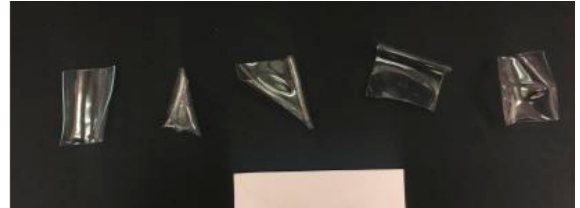
Figure 7. Water bottle squares after 1 h at 100 ◦ C (scale shown with 50.8 mm white bar). Table 1. The 25.4 mm water bottle squares before and after a 1 h heat cycle at 100 ◦ C. Post-Thermal Treatment